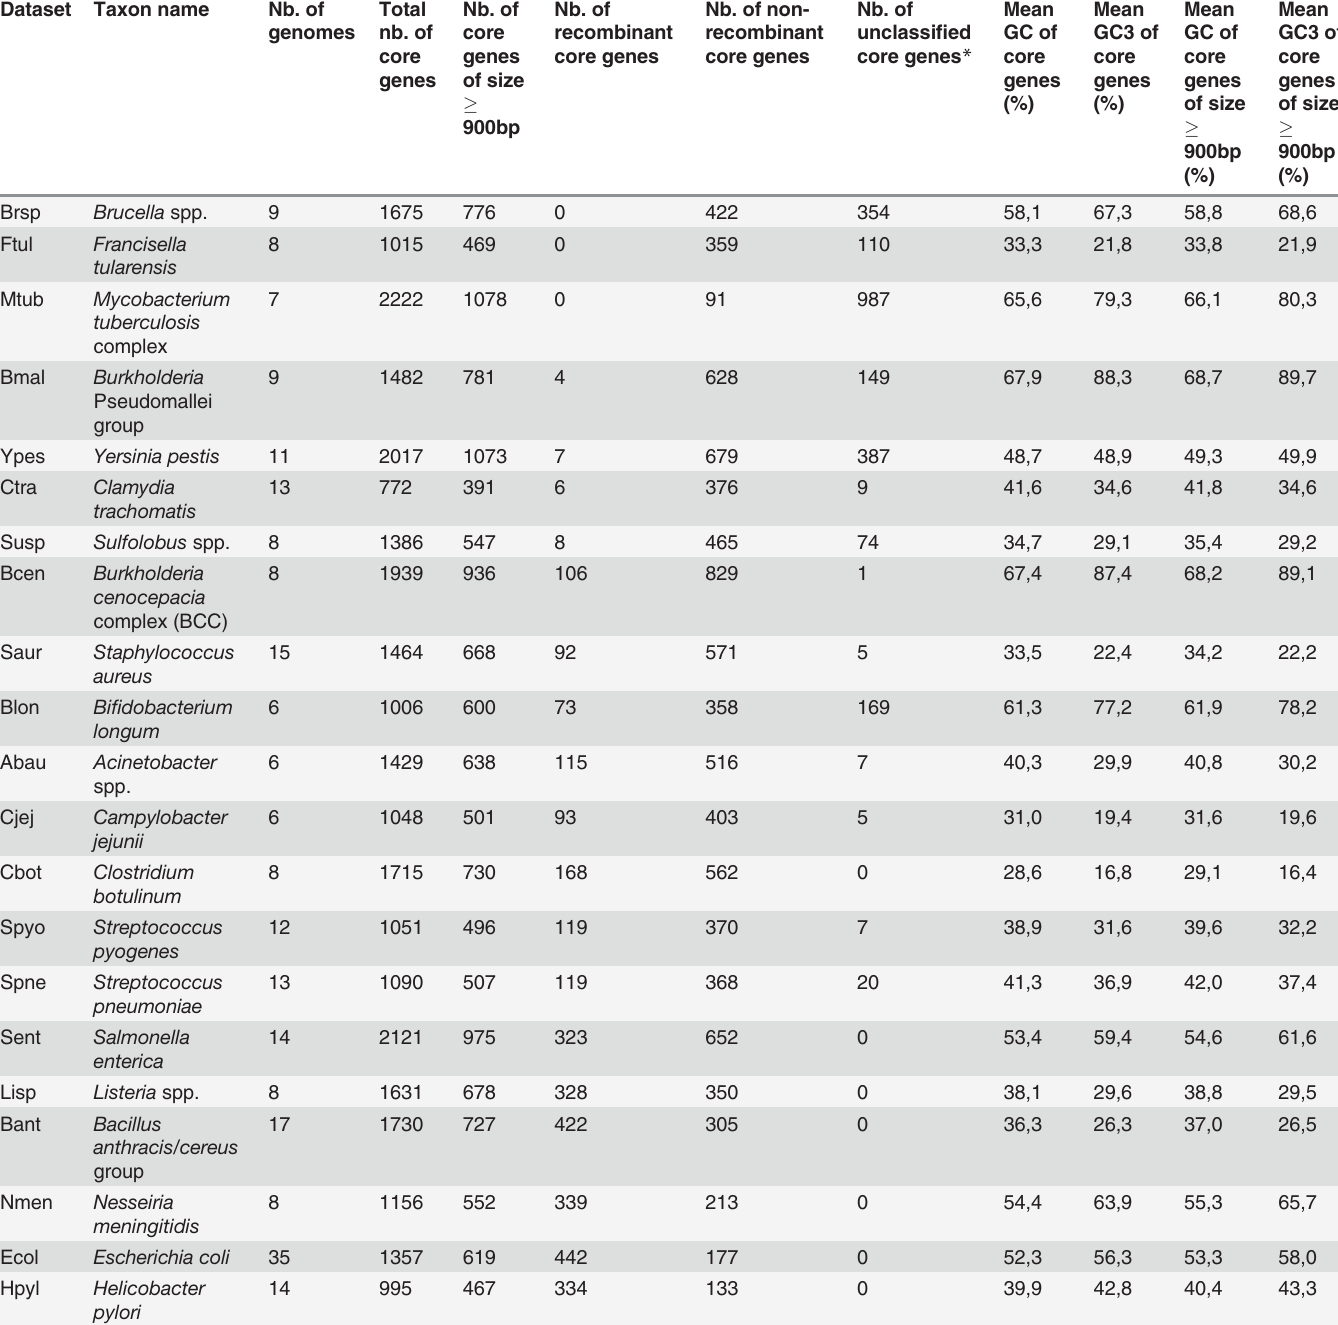
Table 1. Dataset used in this